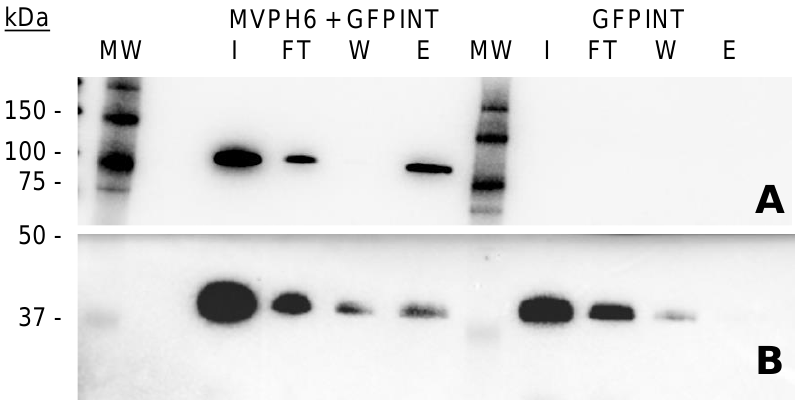
Figure 8. Co-purification of MVP-H6 and GFP-INT proteins. IMAC-based resin was used to purify both MVP-H6 and GFP-INT, as described in Material and Methods. Images correspond to SDS-PAGE and Western blot developed with an anti-His monoclonal antibody ( A ) or a polyclonal antibody anti-GFP ( B ). Legends: initial sample (I), flowthrough (F), wash (W) and eluted (E).